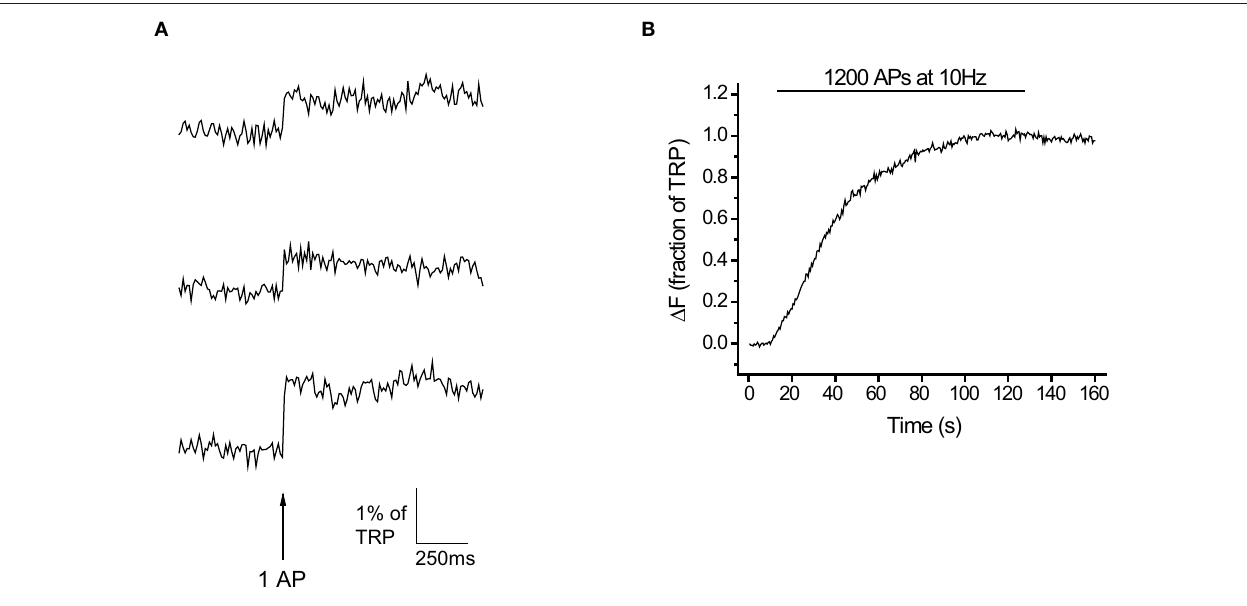
Figure 1 | exocytosis in response to 1 AP measured at 10 ms time resolution with vg-pH. (A) Representative traces of a neuron’s response to 1 AP ( n = 25 synapses). (B) Response to 1200 APs at 10 Hz in the presence of Baf for the same